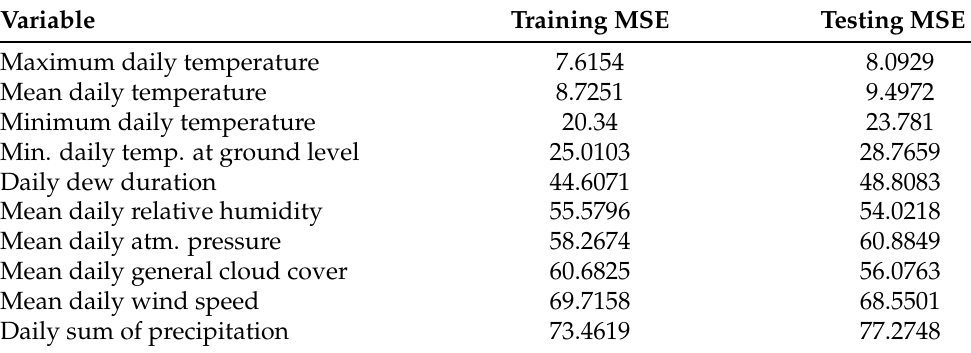
Table 6. The results of the selection of the most suitable subset of the training variables for the prediction of the daily maximum